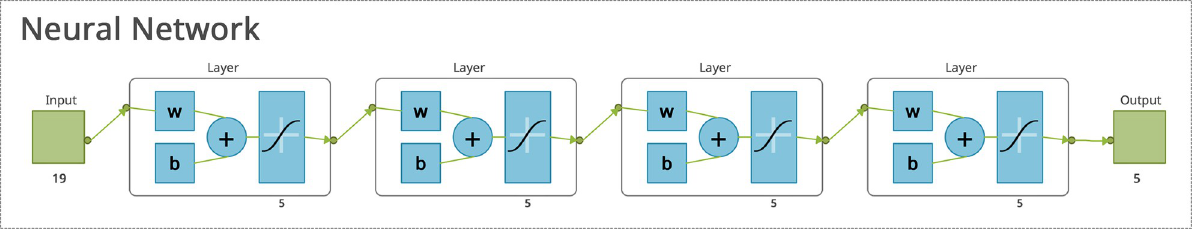
Fig 7. Training phase with optimal number of hidden